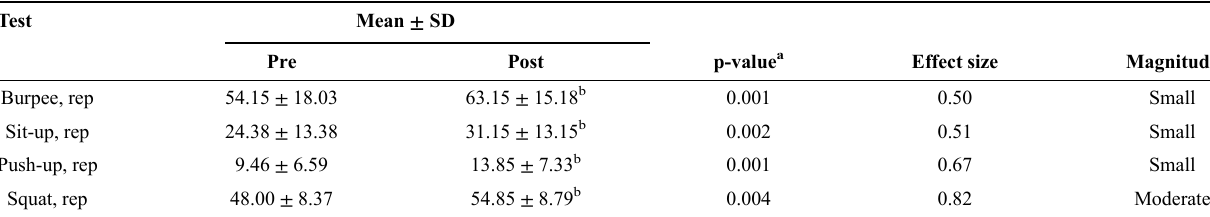
Table 1 - Mean and standard deviation of pre and post-intervention tests (n =